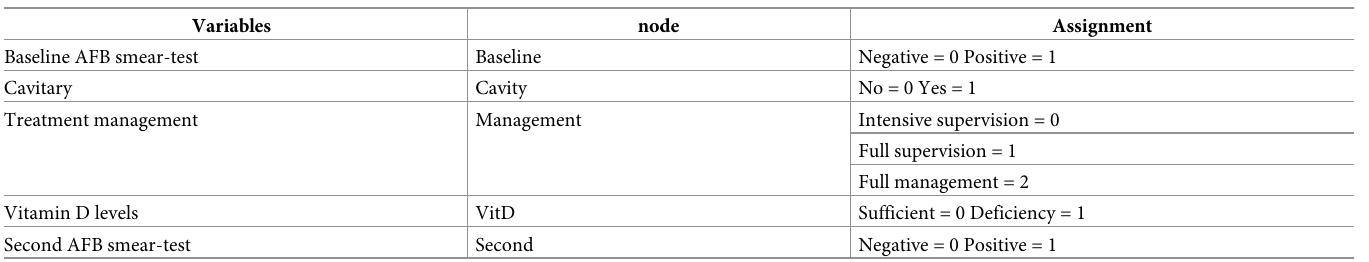
Table 4. The definition and assignment table of Bayesian network nodes.